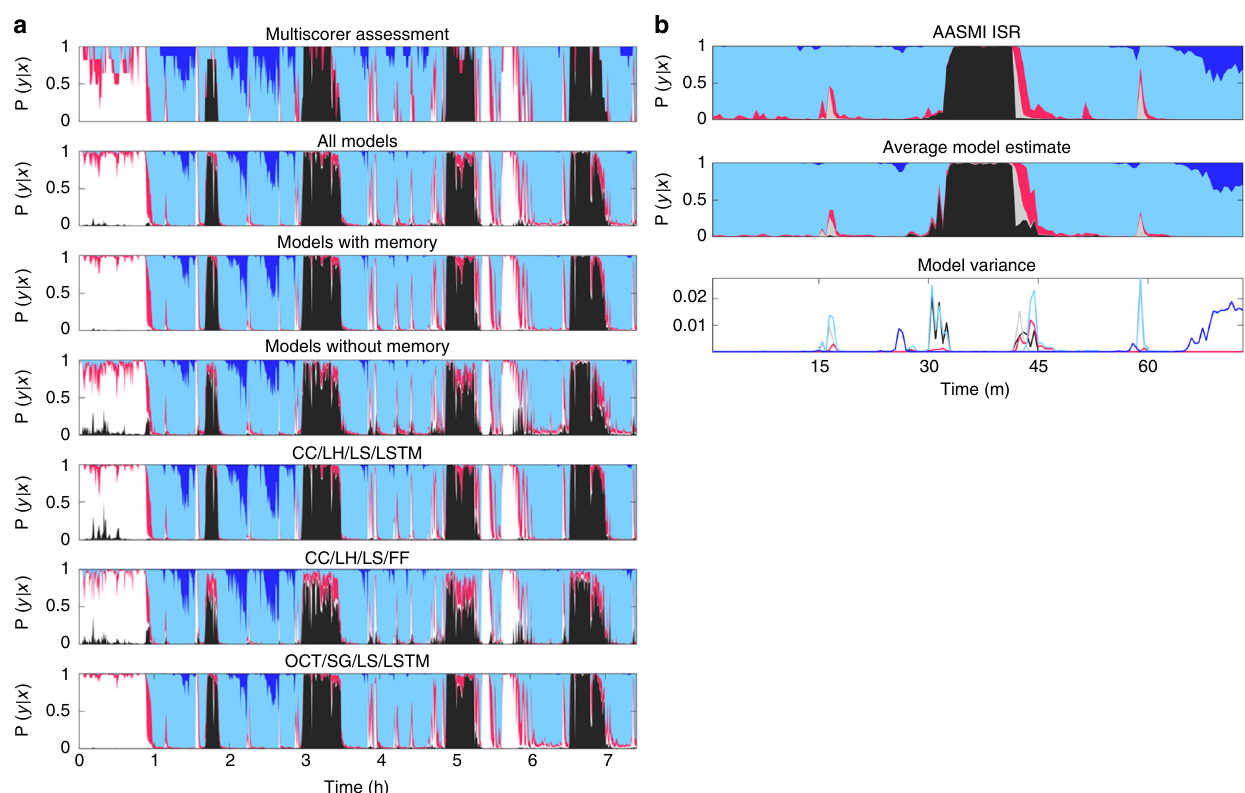
Fig. 2 Hypnodensity example evaluated by multiple scorers and different predictive models. a The fi gure displays the hypnodensity graph. Displayed models are, in order: multiple scorer assessment (1); ensembles as described in Supplementary Table 8: All models, those with memory (LSTM) and those without memory (FF) (2 – 4); single models, as described in Supplementary Table 8 (5 – 7). OCT is octave encoding, Color codes: white, wake; red, N1; light blue, N2; dark blue, N3; black, REM. b The 150 epochs of a recording from the AASM ISR program are analyzed by 16 models with randomly varying parameters, using the CC/SH/LS/LSTM model as a template. These data were also evaluated by 5234 ± 14 different scorers. The distribution of these is shown on top, the average model predictions are shown in the middle, and the model variance is shown at the bottom